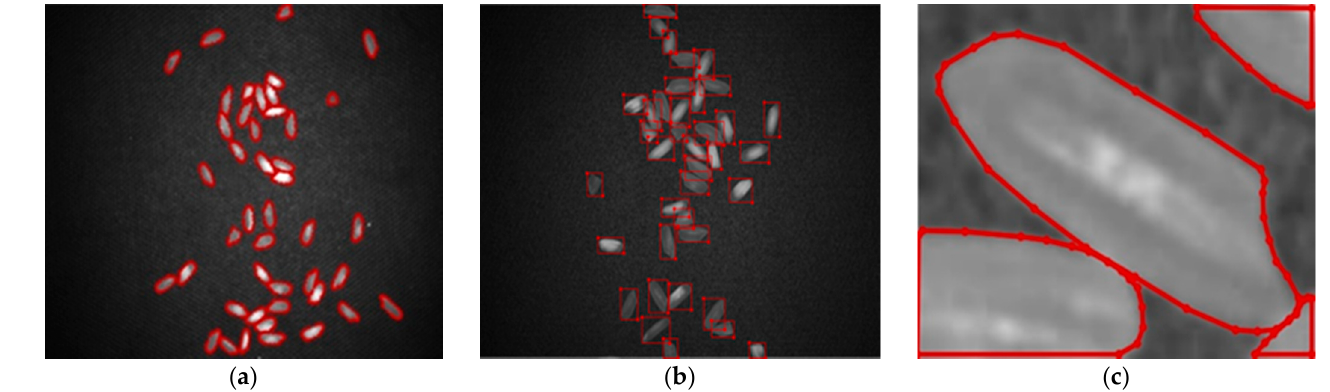
6 of 17 Figure 3. Schematic diagram of the polished rice image acquisition device: 1. hopper; 2. rollers; 3. belt conveyor; 4. toroidal light source; 5. CCD camera; 6. black box. 2.3. Polished Rice Dataset Production A CCD camera with a resolution of 1620 × 1220 was used for the collection of the polished rice images, manually labeled using Labelme, to treat different rice grains as dif- ferent instances of the same class, as shown in Figure 4a,b. Labelme is an open source annotation tool for labeling data required in target detection and image segmentation. In particular, Labelme can generate rectangular or polygon boxes in images, and at the same time produce corresponding json files containing all the boundary coordinate information and labeled object categories in the image. In the labeling process, the image segmentation needs to accurately label the boundary points of each instance, and the target detection only needs to label the approximate positions of each instance (the upper-left vertex and the lower-right vertex of the targets), as shown in Figure 4b,c. Thus, the pixel-level anno- tation of the image segmentation was more difficult than the object-level annotation of the target detection. In the annotation of the whole polished rice images and small polished rice images, the workload of the former was much greater than the latter, due to the dif-